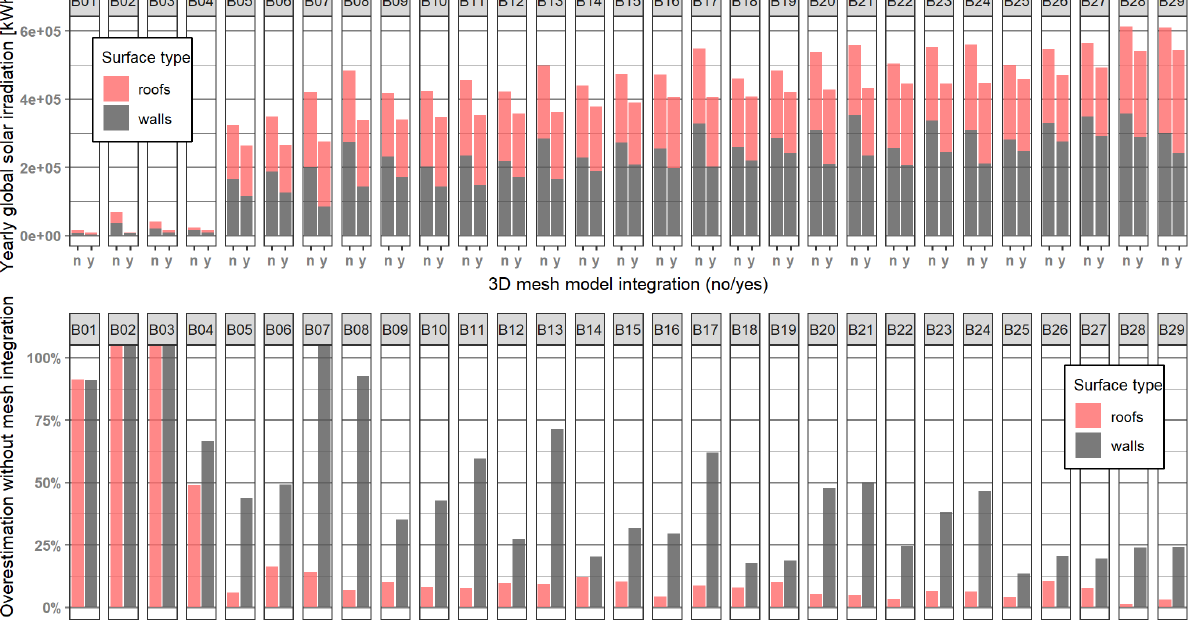
Figure 9. Impact of the 3D mesh integration on the solar potential anaysis. The top chart shows the absolute changes in yearly global solar irradiation [kWh] on wall and roof surfaces per building (building numbers at the top), while the bottom chart shows the overestimation of solar irradiation when running the simulation without incorporating of the additional shadowing features from the 3D mesh.